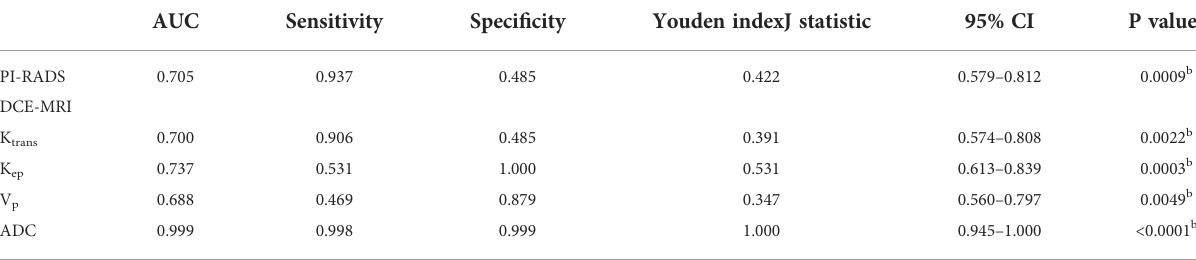
TABLE 3 Diagnostic performance of imaging parameters and PI-RADS score in discriminating between PCa vs BPH. AUC Sensitivity Speci fi city Youden indexJ statistic